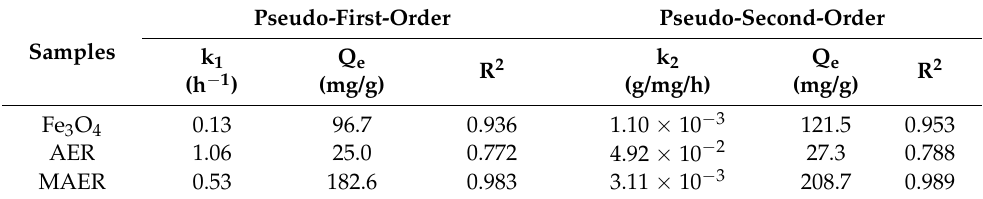
Table 1. Kinetic parameters of adsorption process.